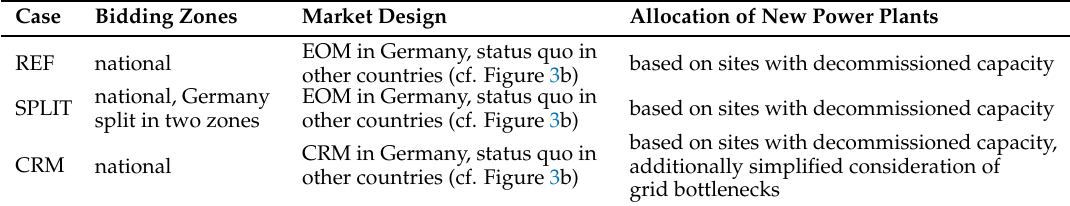
Table 1. Overview of the investigated cases. The REF case reflects the current status quo in the real world and serves as a benchmark for the other cases. In the SPLIT case, the German market area is split into two zones in order to consider grid congestion already at the market clearing stage. The CRM case investigates the introduction of centralized capacity auctions with an additional grid indicator in Germany. This instrument aims to steer the allocation of new generation